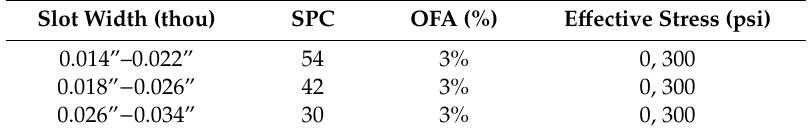
Table 2. Testing matrix to study the role of slot density at constant slot width. Slot Width (thou)